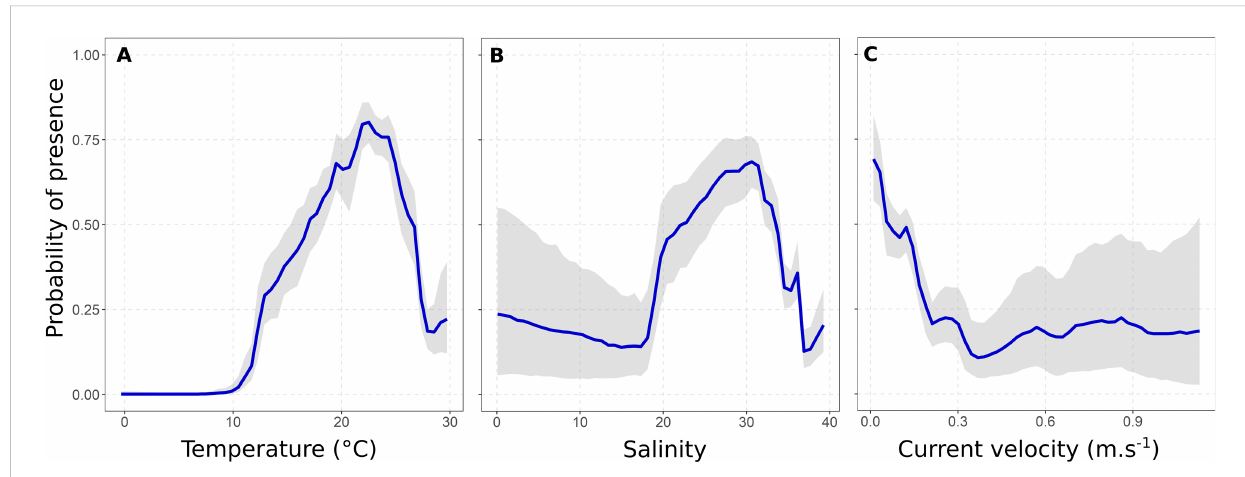
FIGURE 2 Smoothed fi ts of covariates modeling the spatial distribution of the Atlantic blue crab Callinectes sapidus Rathbun, 1896 for temperature (A) , salinity (B) , and current velocity (C) . Gray shading indicates a 95% credible interval from the posterior distribution of the current scenario BART